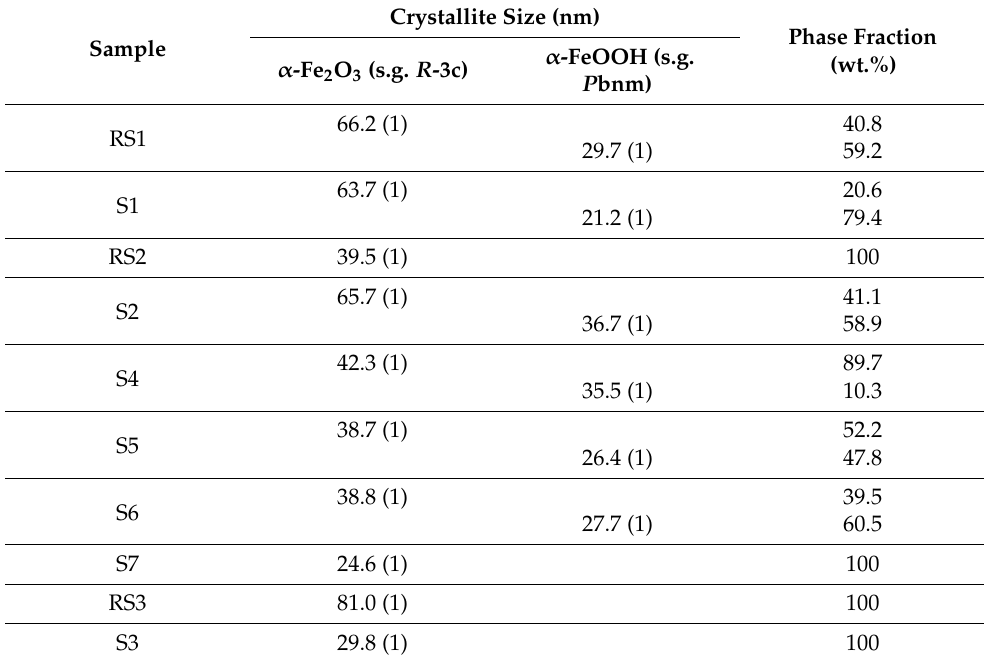
Table 3. Results of crystallite size calculation as obtained from the phase refinements to PXRD